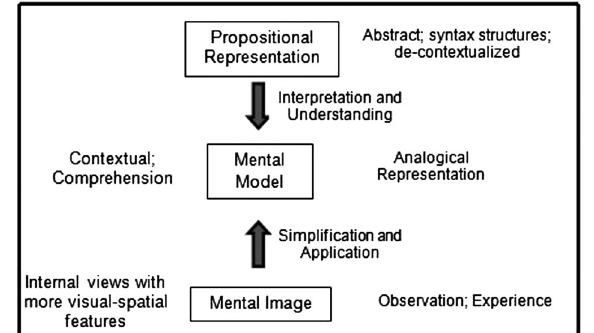
FIG. 1. Types of mental representations according to Johnson- Laird cognitive framework